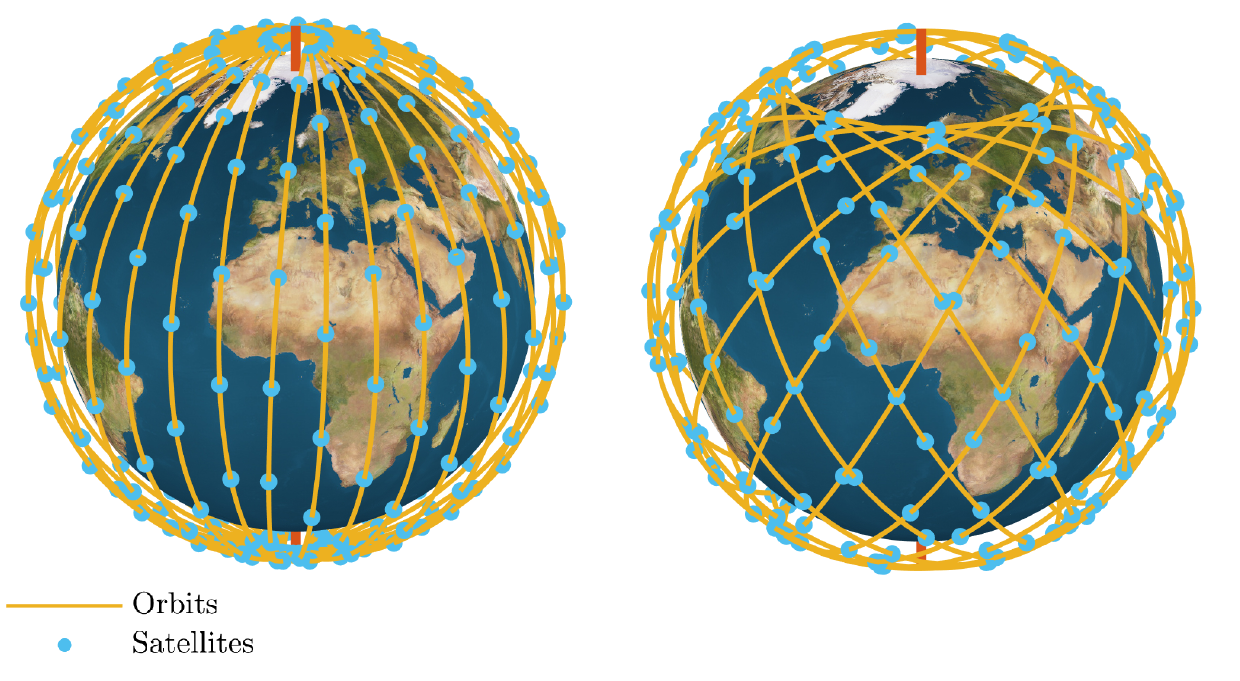
Figure 6. Illustration of the Walker-Star ( left ) constellation for { h = 550 km, i = 87.5 ◦ , N = 240, P = 16, F = 8 } and Walker-Delta ( right ) constellation for { h = 550 km, i = 70 ◦ , N = 240, P = 16, F = 8 } . Mercator projection of both Walker-Star and Walker-Delta constellations are shown in Figure 7, where the blue patches represent the footprint of the satellites in the constellation. The constellation parameters are summarized in Table